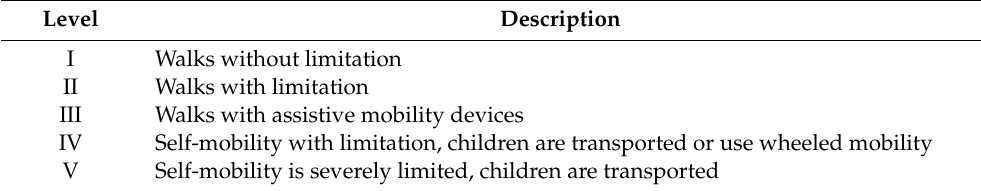
Table 1. The level description of Gross Motor Function Classification System (GMFCS).